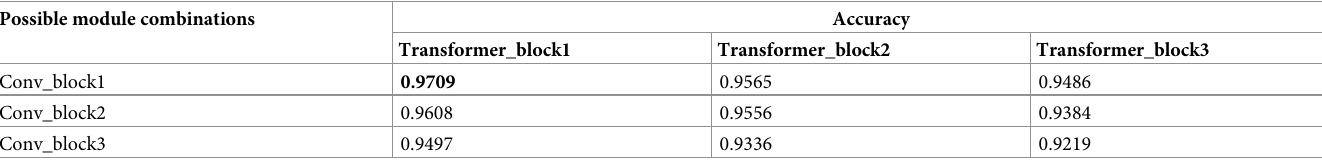
Table 5. Performance comparison of the proposed model with possible module combinations.